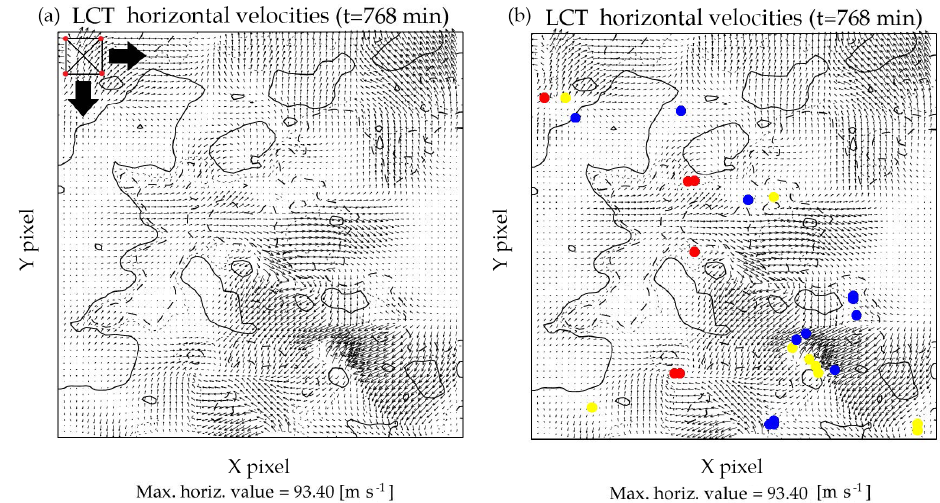
Figure 3. (a) Illustration of the method for automatic search of critical points in a 2-D flow field. (b) Results obtained using the automatic search for the LCT flow field at t = 768min. The circles show the location of the suggested critical points, and the colors show their classification (blue is saddle point, red is attracting node or focus, and yellow is repelling node or focus). Table 1. Classification of critical points according to the values of the real ( R ) and imaginary ( I ) parts of the eigenvalues. Critical point type Real part of the eigenvalues Imaginary part of the eigenvalues Saddle